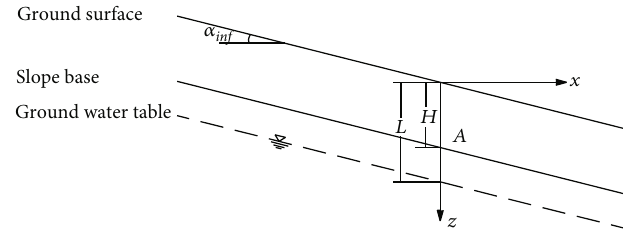
Figure 1: Sketch of an in fi nite